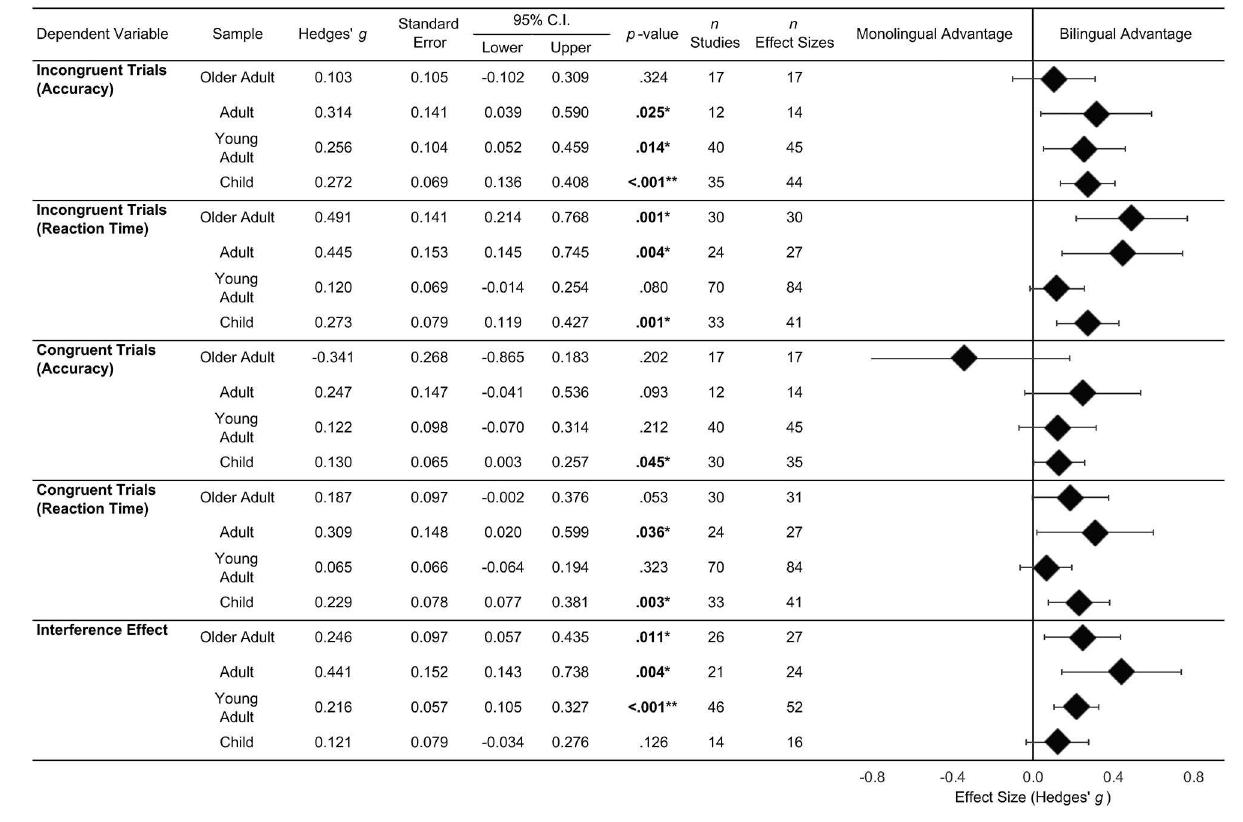
FIGURE 5 | Average effect sizes reported by Age Group, Trial Type, and for accuracy and reaction time data. No interference effect, effect sizes were available for the Card Sort Tasks and Trail Making Test. * p < 0.05; ** p <